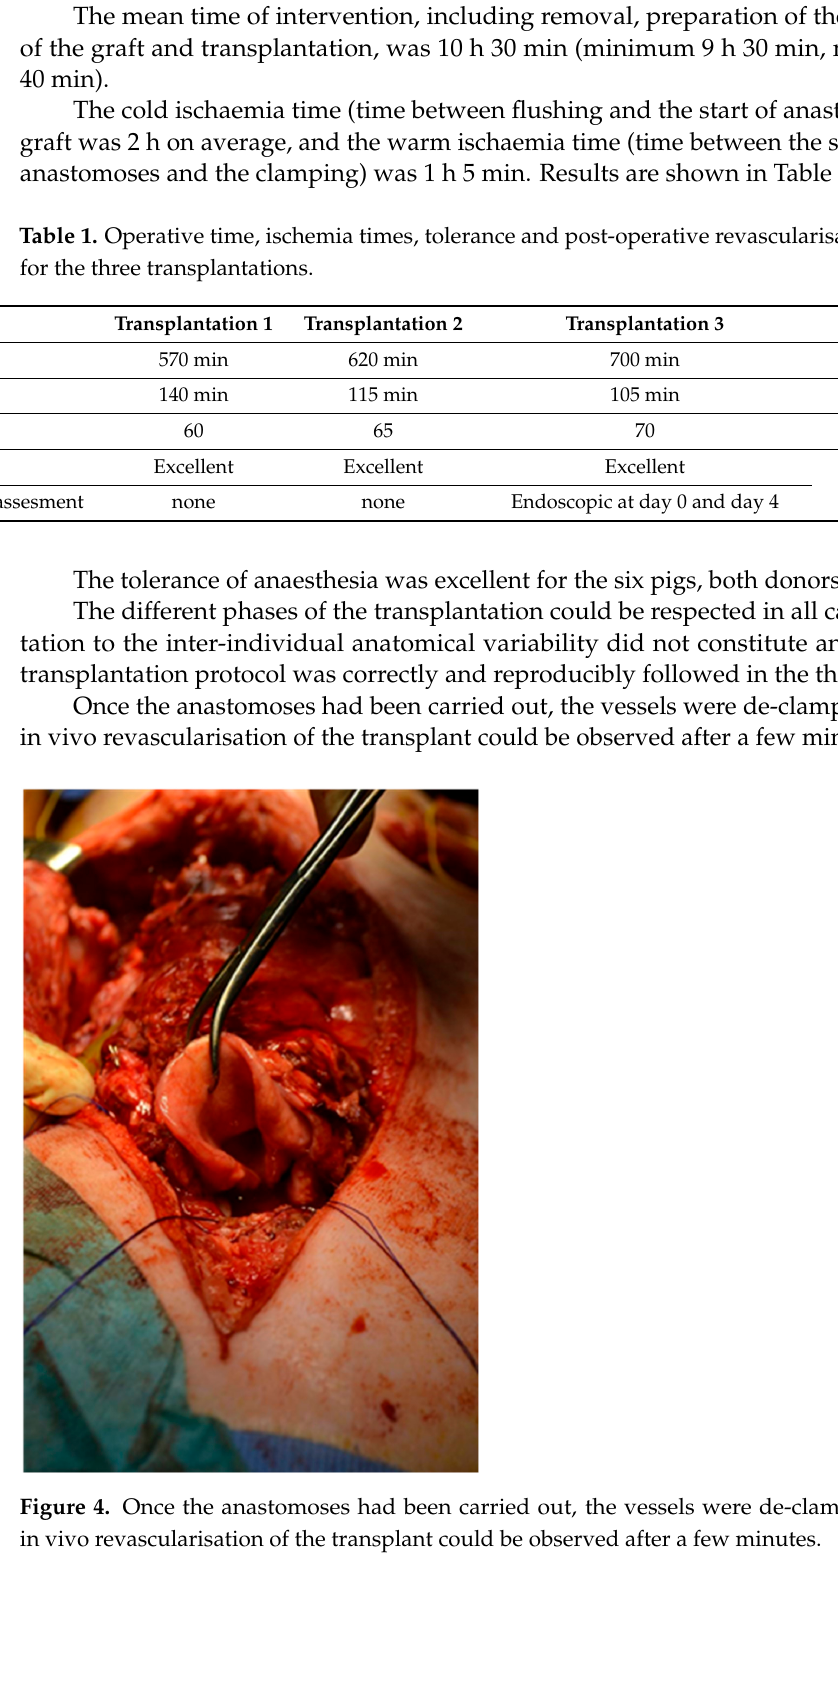
Figure 5. Endoscopy immediately performed after the surgery in the third recipient animal con- firmed the correct revascularisation of the transplant . The animal was monitored for four days with no significant problems. Endoscopy on the fourth day confirmed the viability of the transplant. The animal died on the fifth day after the operation, and the autopsy revealed massive mesenteric infarction.